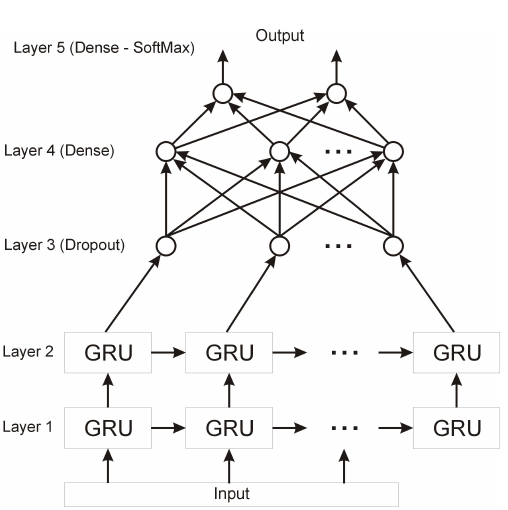
Figure 11. Neural network